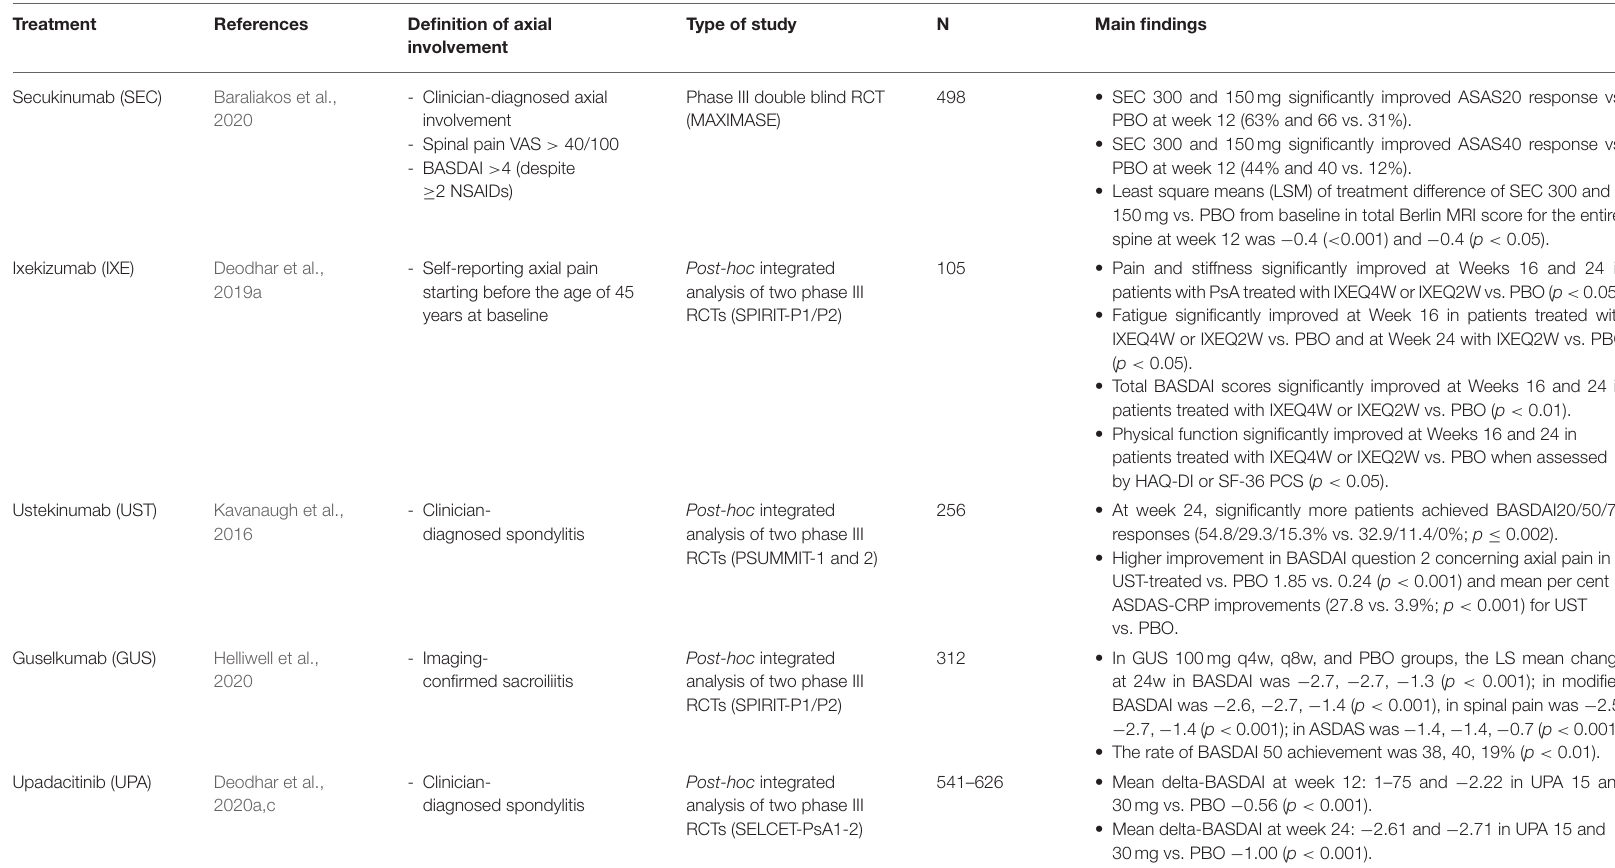
TABLE 1 | Summary of studies specifically designed to assess the effectiveness of different biologic DMARDs in patients affected by psoriatic arthritis with axial involvement.